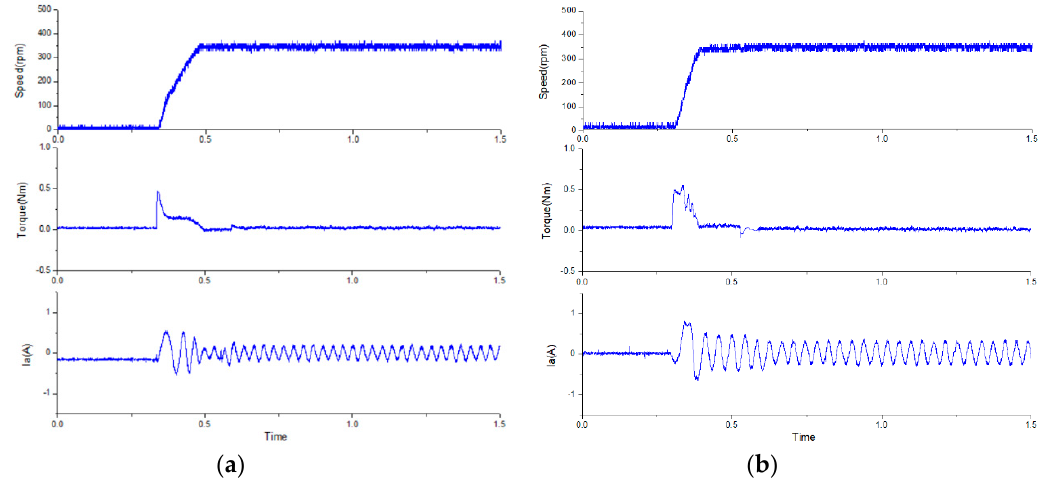
Figure 12. The step response for no load at a speed of 350 rpm: ( a ) the traditional PI control, and ( b ) the proposed modified MPCC.